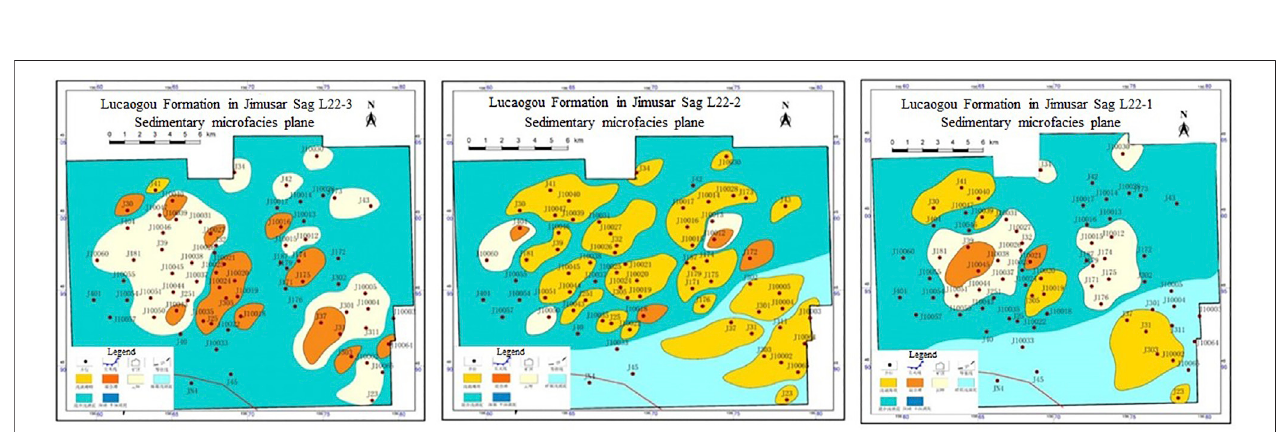
FIGURE9| Sedimentarymicrofaciesplanedistribution intheuppersweetspotoftheLucaogouFormationintheJimsarSag. (A) Sedimentarymicrofaciesplaneof P 2 l 22 − 3 . (B) Sedimentary microfacies plane of P 2 l 22 − 2 . (C) Sedimentary microfacies plane of P 2 l 22 − 1 .